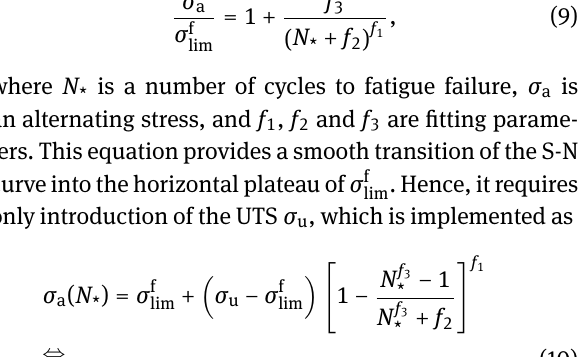
In general, each S-N curve exhibits two limits: one, when stress tends towards the static fracture σ u (fracture in a quarter of the cycle), and the other, when stress tends towards the fatigue limit σ . The most known concepts lim able to describe a reverse sigmoidal shape of a generic S-N curve are presented by two models. The conventional one is the Bastenaire model [37,